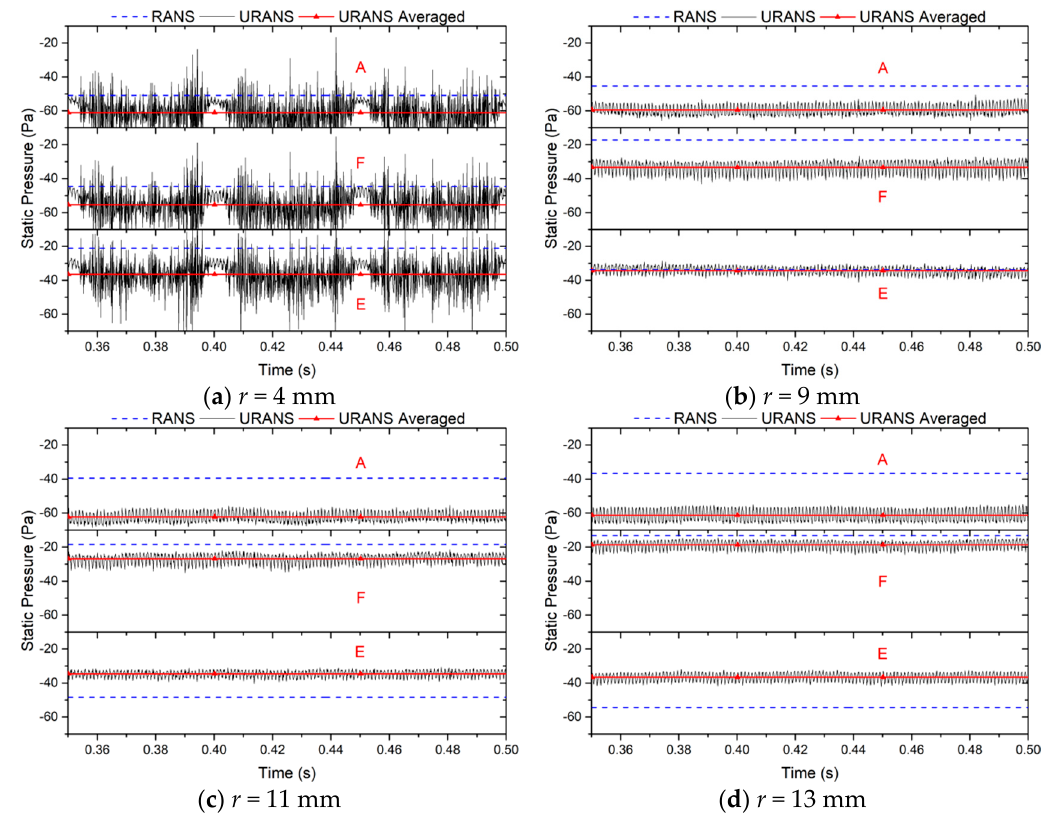
Figure 22. Static pressure fluctuation at monitors A/E/F.